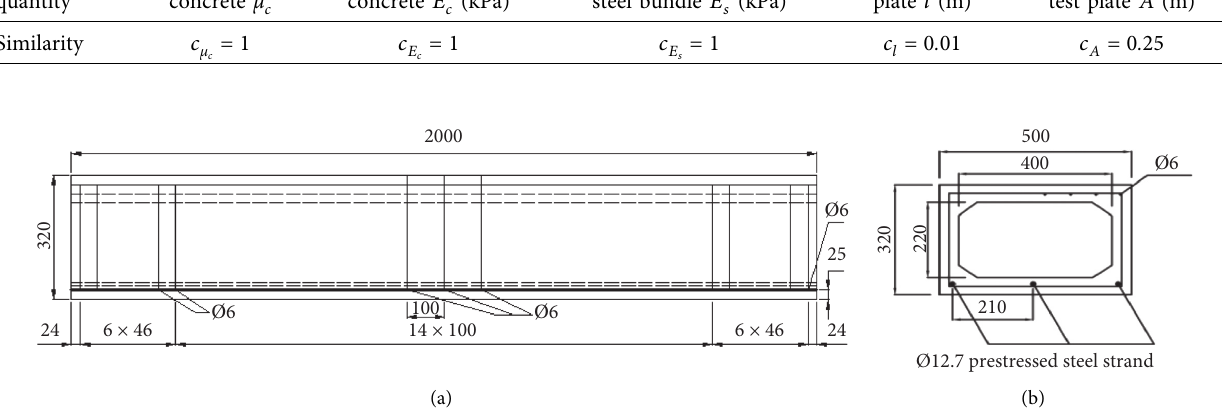
Figure 1: Cross section, longitudinal section, and bar arrangement drawing of test plate: (a) longitudinal section and (b) cross section.